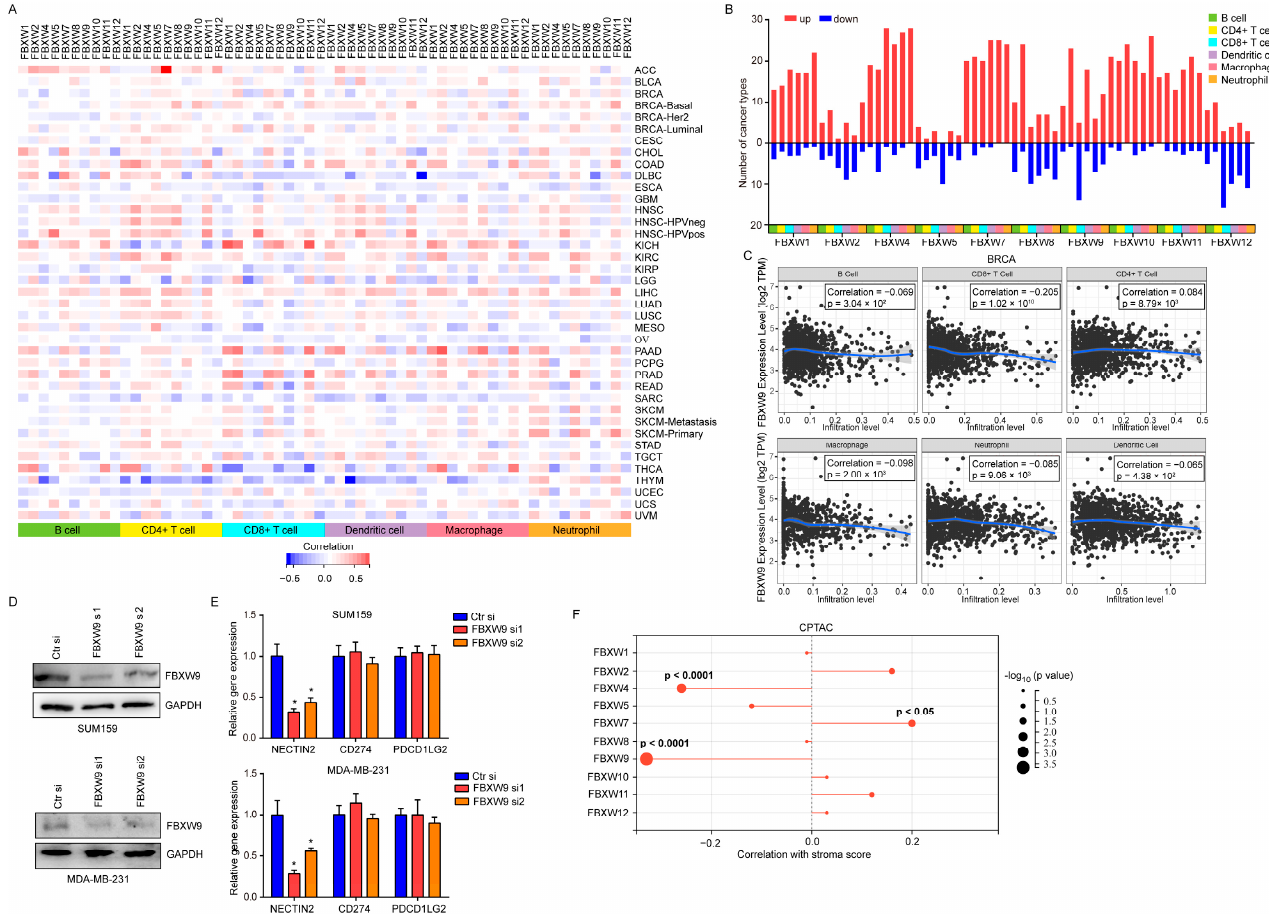
Figure 3. Pan-cancer analysis of expression of FBXWs, tumor microenvironment, and the overall survival of patients receiving anti-PD1 therapy.